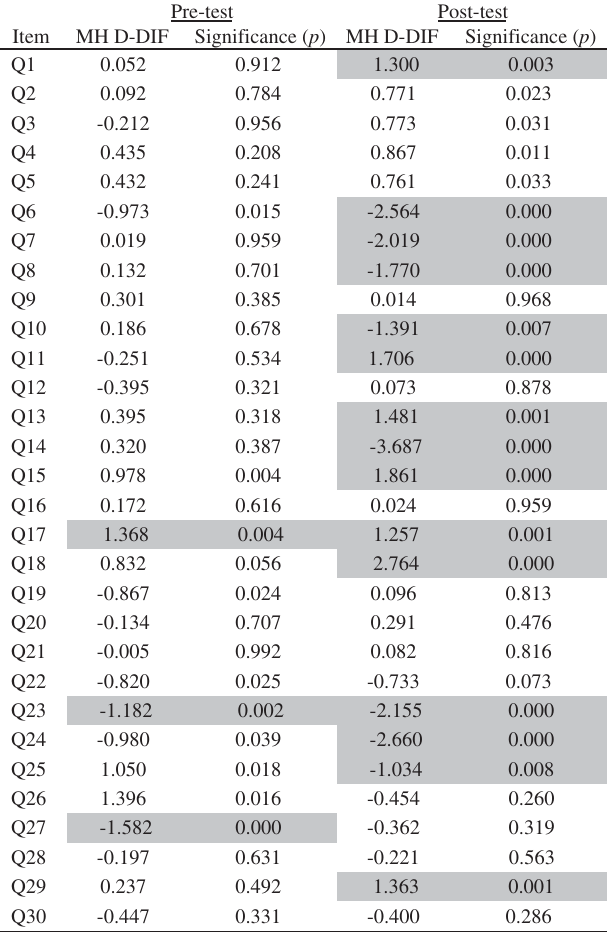
FIG. 5. MH D-DIF values and significance levels for the FCI items. Items containing significant DIF are